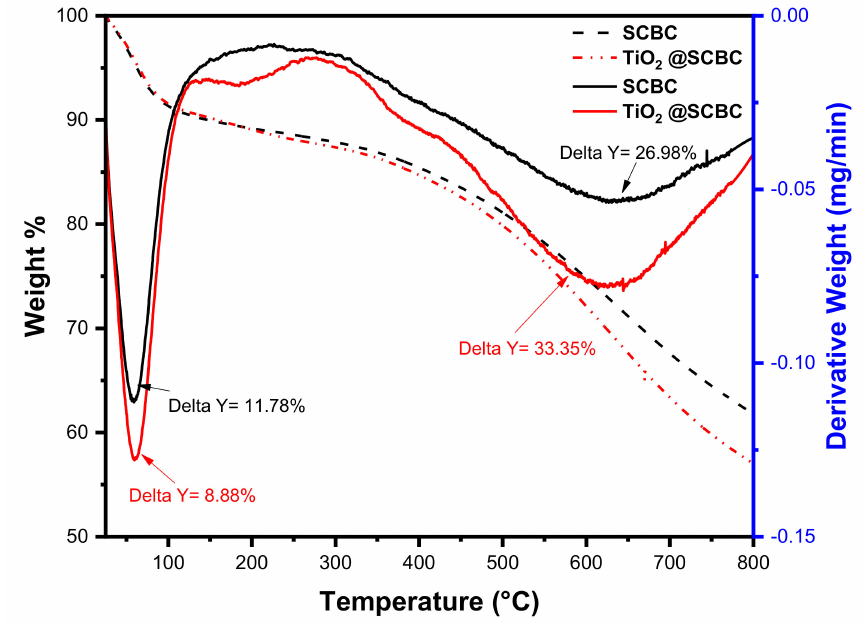
Figure 1. TG/ d T spectra of SCBC and TiO 2